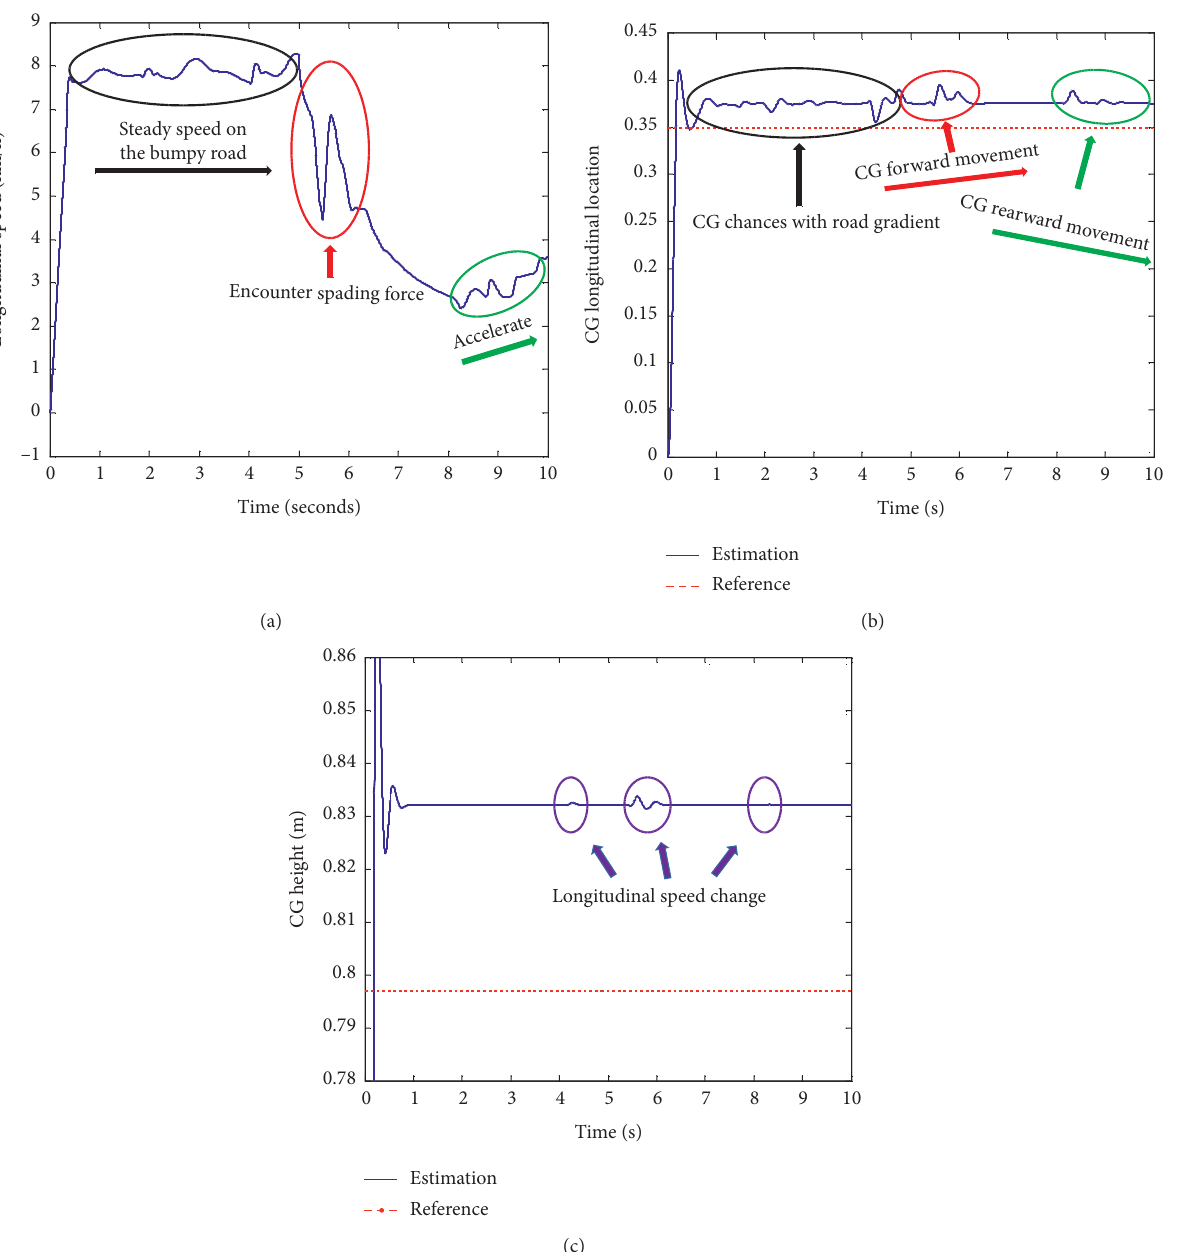
Figure 5: Simulation results during driving with spading conditions on a bumpy road. (a) Longitudinal speed. (b) CG longitudinal location. (c) CG